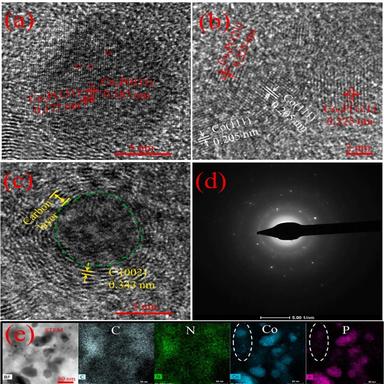
Characterization of Co-Co2P @ NC: (a-c) HRTEM; (d) SAED pattern; (e) STEM and corresponding EDS elemental mapping images.